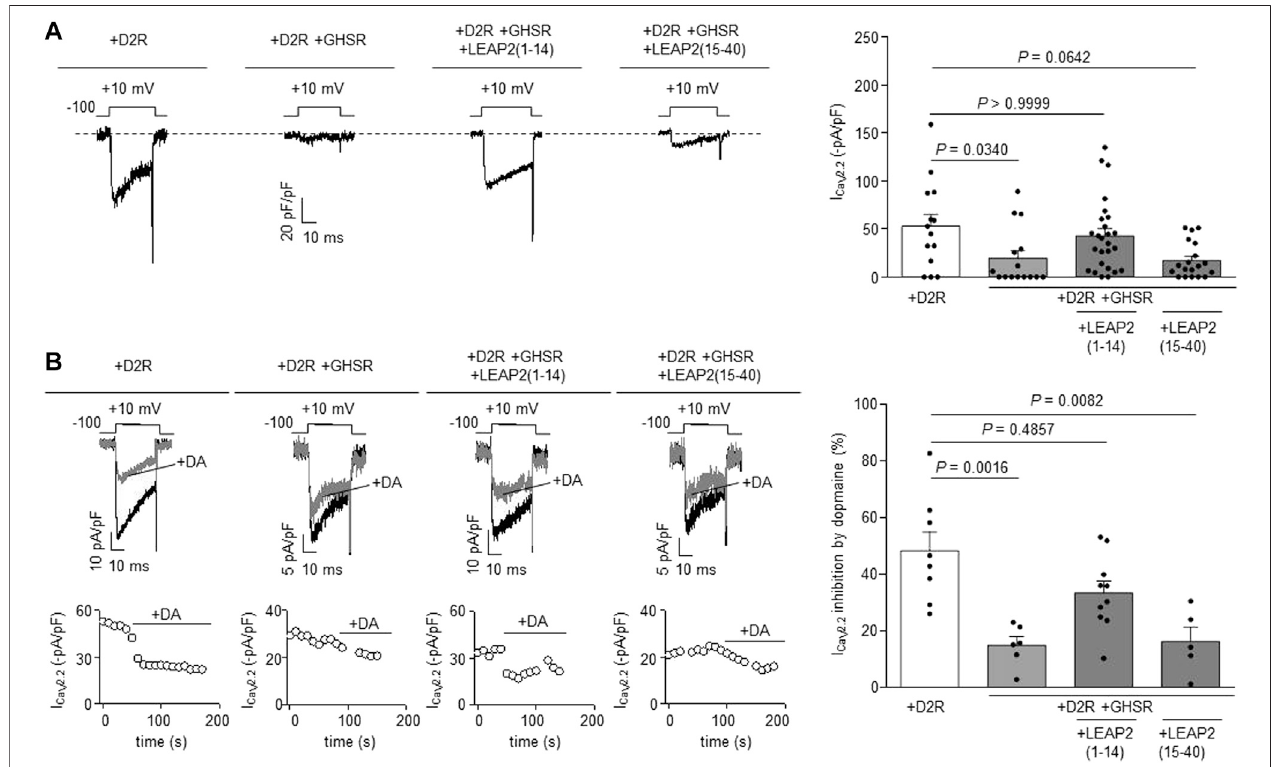
FIGURE3| LEAP2(1-14)impairsGHSRmodulationofD2Rsignaling. (A) Representativetraces (left) ofCa V 2.2current(I CaV2.2 )fromHEK293Tcellscotransfected with Ca V 2.2, Ca V β 3 , Ca V α 2 δ 1 and either D2R (+D2R, n (cid:2) 14) or GHSR and D2R (+D2R +GHSR, n (cid:2) 16) pre-incubated or not with 0.1 µM LEAP2 (1 – 14) [+D2R +GHSR +LEAP2 (1 – 14), n (cid:2) 26] or 0.1 µM LEAP2 (15 – 40) [+D2R +GHSR +LEAP2 (15 – 40), n (cid:2) 19] in a 0.1 GPCR:Ca V 2.2 molar ratio. Bars (rigth) represent averaged I CaV2.2 levelsforeachcondition.Statisticalsigni fi cancewasevaluatedbyKruskal-WallisandDunn ’ spost-test(versus+D2Rcondition). (B) Representativetracesandtime courses (left) ofCa V 2.2 current (I CaV2.2 )from HEK293Tcellscotransfected with Ca V 2.2, Ca V β 3 , Ca V α 2 δ 1 and D2R(+D2R, n (cid:2) 8) or GHSR and D2R pre-incubatedor not (+D2R+GHSR, n (cid:2) 6) with 0.1 µM LEAP2 (1 – 14) [+D2R +GHSR +LEAP2 (1 – 14), n (cid:2) 10] or 0.1 µM LEAP2 (15 – 40) [+D2R +GHSR +LEAP2 (15 – 40), n (cid:2) 5] in control condition and after dopamine application(10 µM, +DA); 0.1 GPCR:Ca V 2.2 molar ratio. Bars (right) represent averaged I CaV2.2 inhibition by 10 µM dopamine application for each condition. Statistical signi fi cance was evaluated by Kruskal-Wallis and Dunn ’ s post-test (versus +D2R). The test-pulse protocol consisted in square pulses applied from − 100 to +10 mV for 30 ms every 10